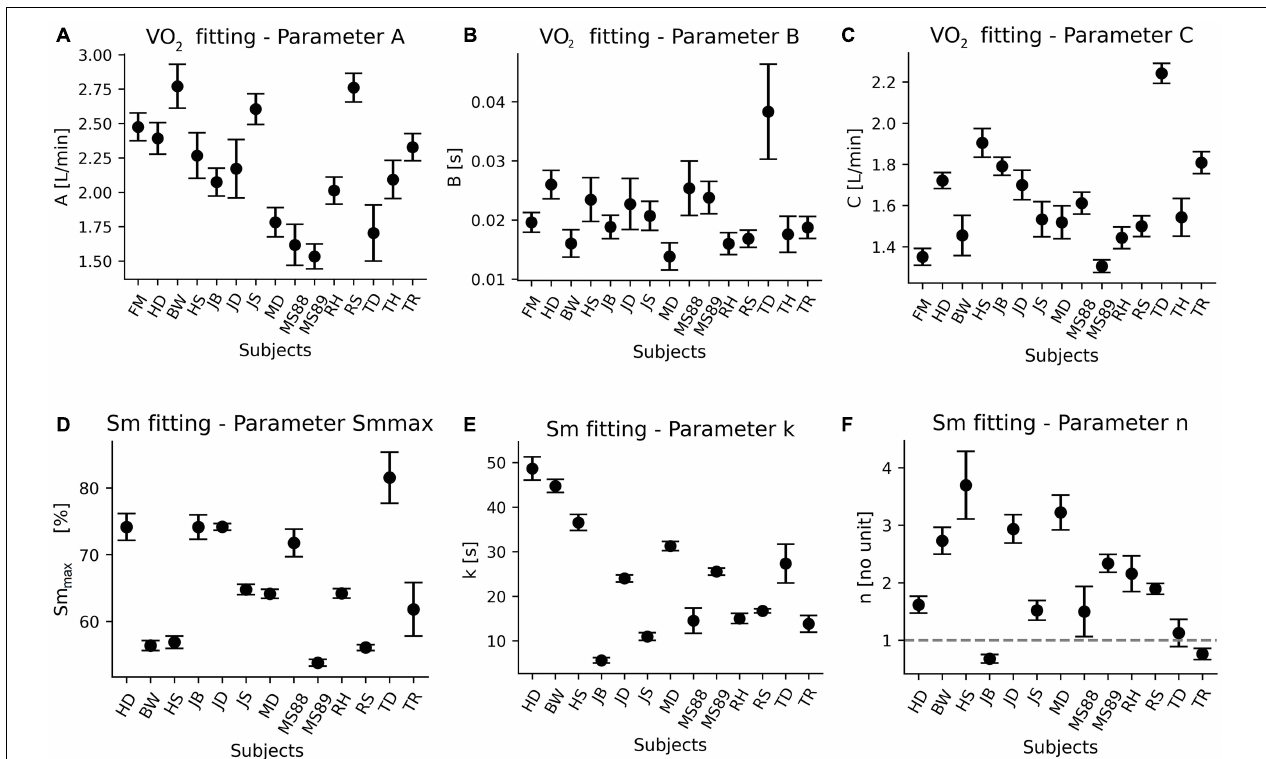
FIGURE 3 | Values of estimated parameters and 95% confidence intervals obtained from oxygen uptake (VO 2 ) and percentage oxyhemoglobin concentration (Sm) signals in the group of healthy subjects. 95% confidence interval was calculated on the basis of the standard error value in accordance with the relationship: 1.96 * standard error. Values of the A (A) , B (B), and C (C) coefficients are determined from exponential model (Eq. 1) and Sm max (D) , k (E) , n (F) are estimated from Hill’s equation (Eq.